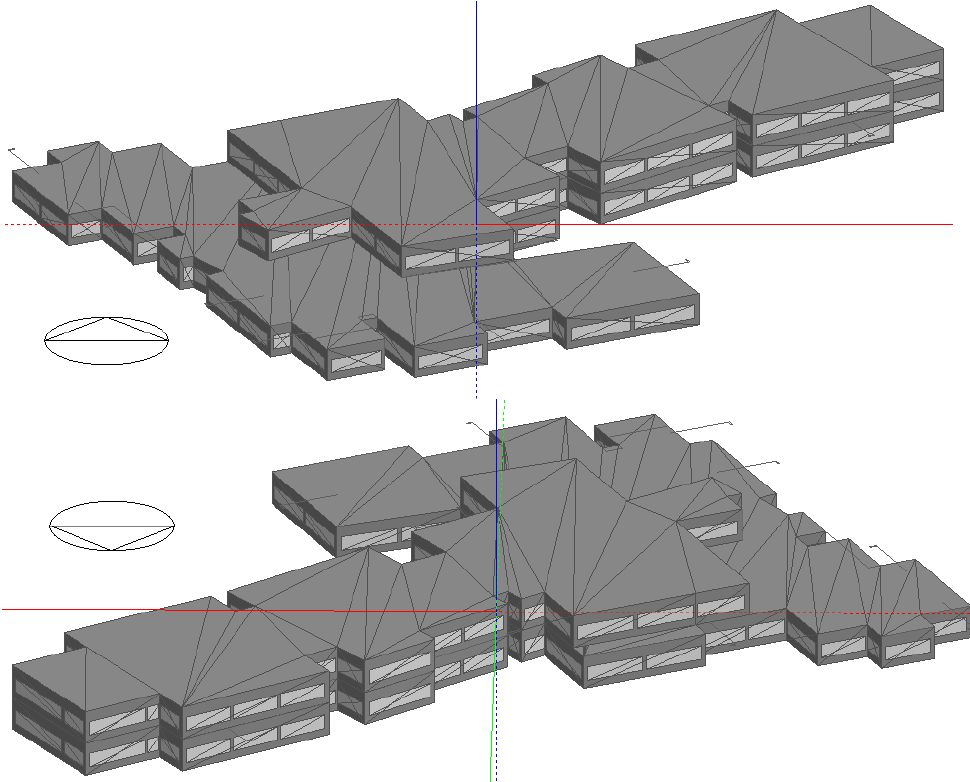
Figure 2. 3D model of test building in DesignBuilder.